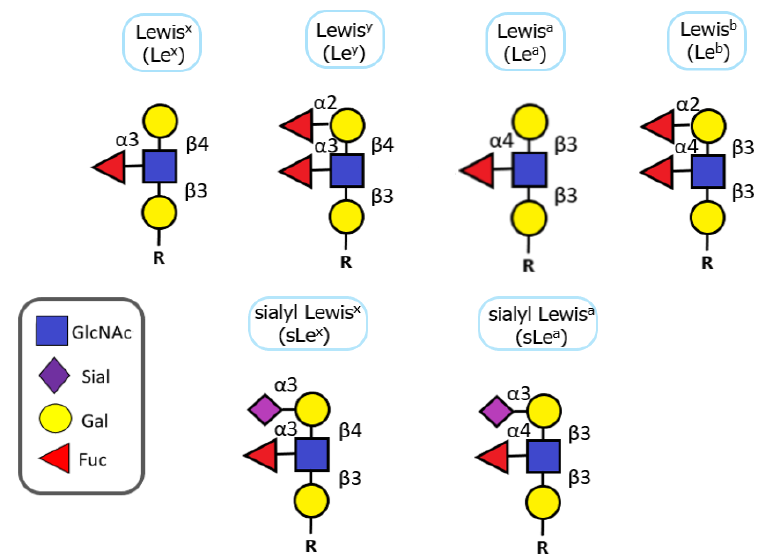
Figure 6. Types of Lewis (Le) antigens and their sialylated forms. Le antigens are terminal fucosyl- ated carbohydrates present on the cell surface, glycoproteins, or glycolipids. Lewis antigens are co- valently attached to the protein by binding to asparagine (Asn) or serine and threonine (Ser/Thr) residues. The presence of Lewis antigens is dependent on the expression of fucosyltransferase